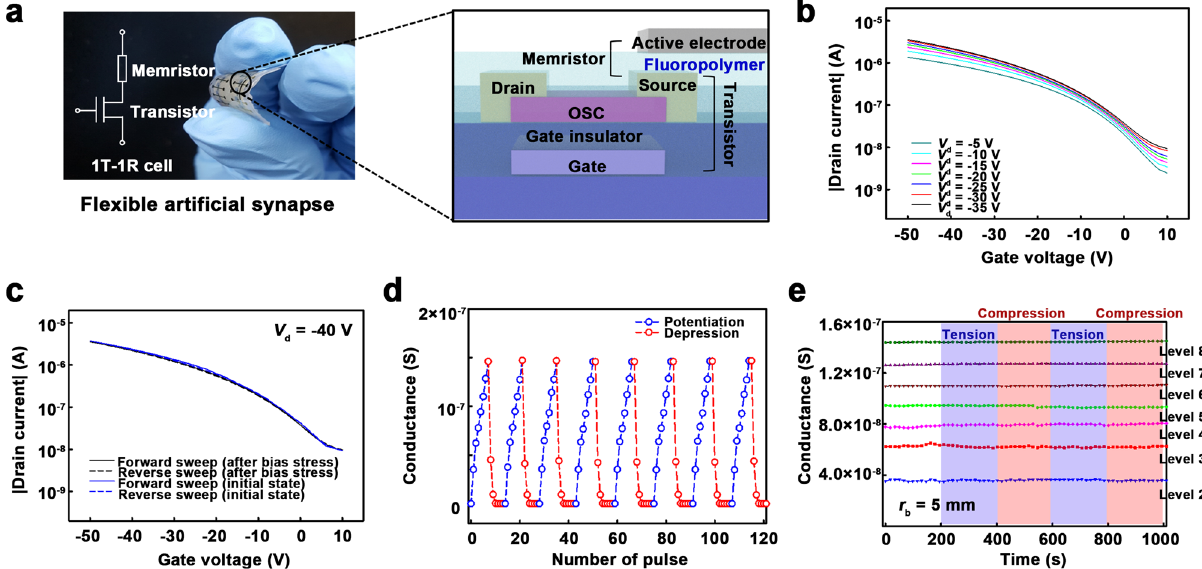
Fig. 3 Electro-mechanical characterization of the arti fi cial synapse cells. a Photographic image of the fl exible arti fi cial synapse under a bending stress. Inset image shows the schematics illustrating the developed synapse cell structure. For the organic transistor, 50-nm-thick pentacene was used as the semiconducting layer. The channel width and length of the transistor were 1 mm and 150 μ m, respectively. The thickness of the fl uoropolymer fi lm was 320 nm, and the active area of the memristor was 0.15 mm × 0.5 mm. b Transfer characteristics of the organic transistor for the synapse cell. c Transfer characteristics of the organic transistor in the initial state and after the application of bias stress. For the bias stress, the gate voltage of − 40 V was applied to the device for 1000 s. d Reliable multilevel memory properties of the arti fi cial synapse. e Mechanical and electrical stabilities of the synapse in seven memory